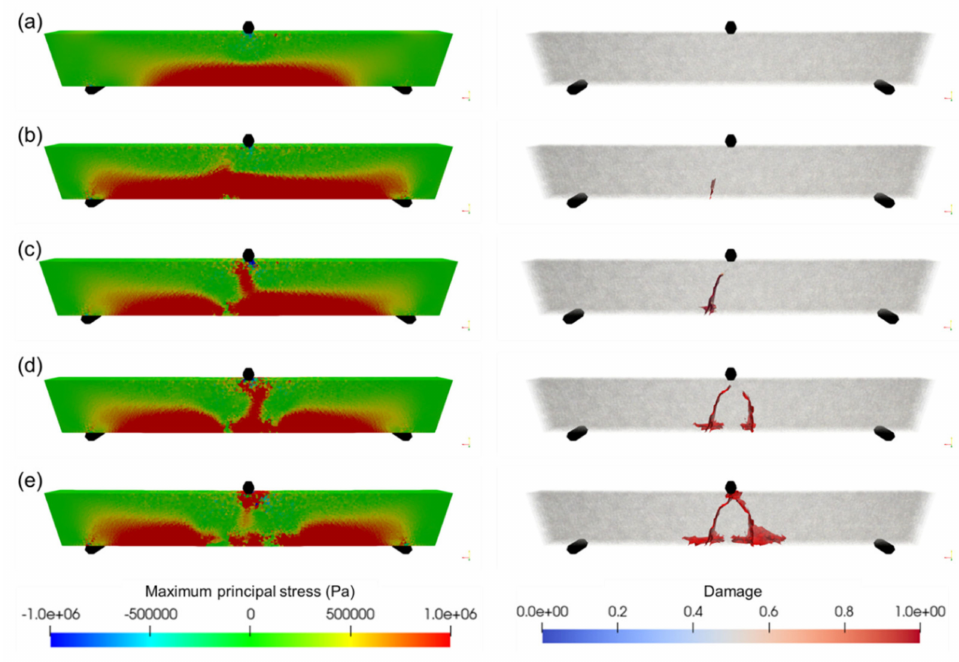
Figure 8. Spatial distribution of maximum principal stress ( left column ) and macroscopic crack ( right column ) in the RC beam subjected to the three-point loading.